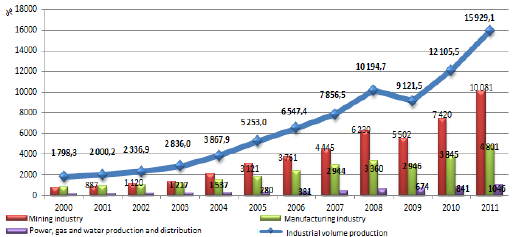
Fig 1. Dynamics of industrial production and industrial sectors for 2000-2011.